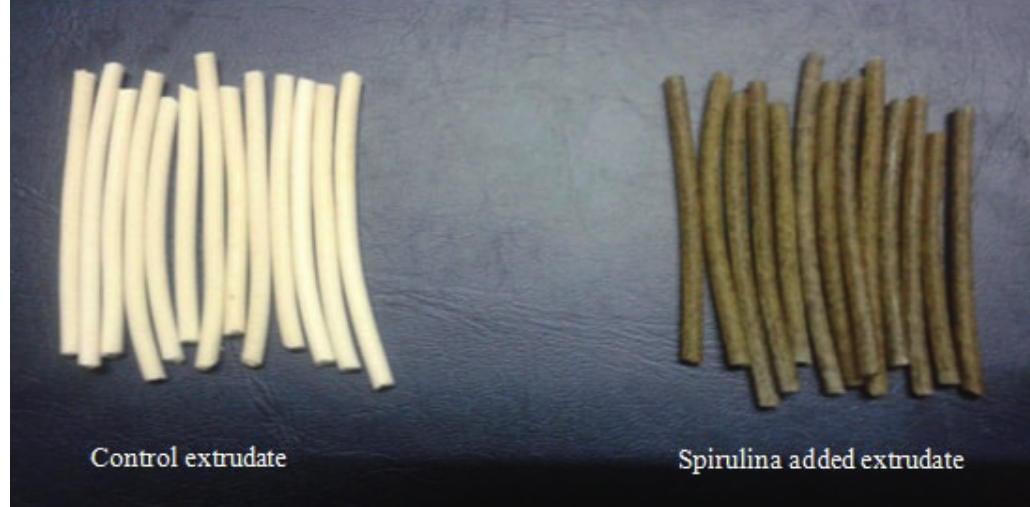
FIGURE 1 - Photographic images of rice extrudate (control i.e. without addition of spirulina) and rice-spirulina (97:03) blend